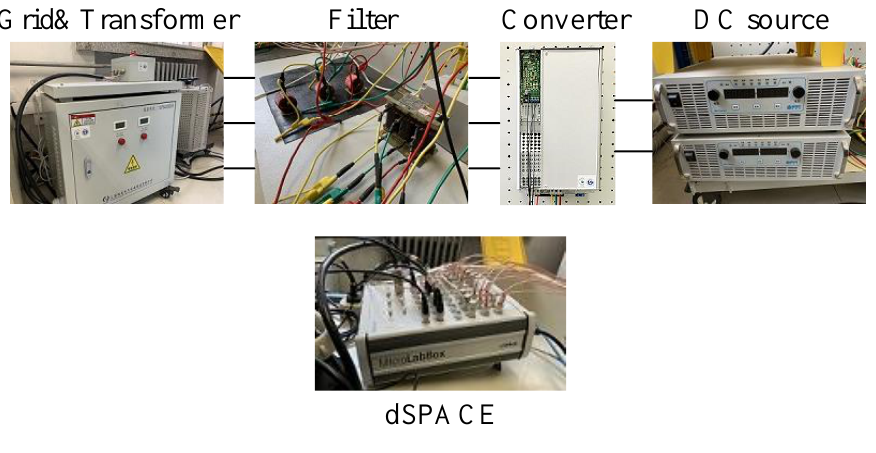
Figure 18. Experimental setup.